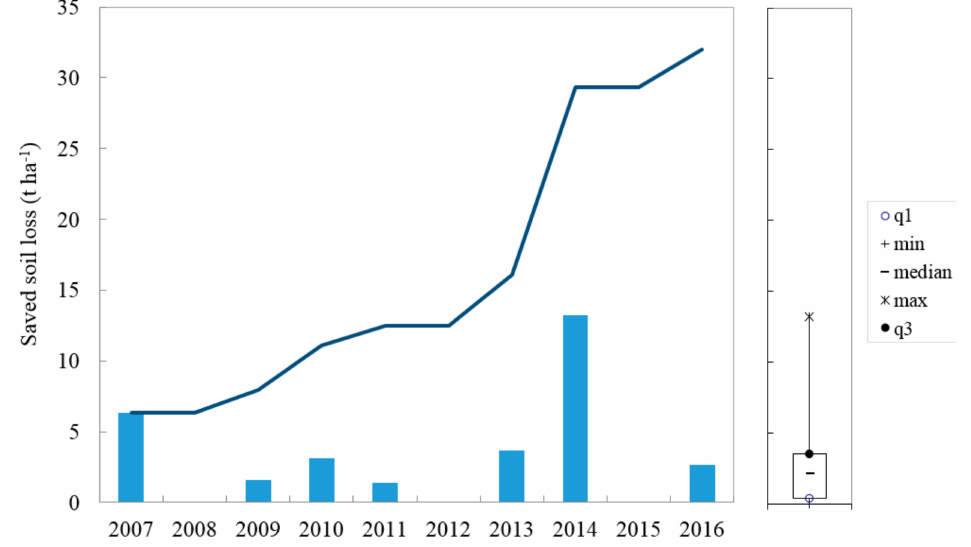
Figure 11. Impact of BMP scenario on saved soil loss. Solid line is the cumulative saved soil loss, whereas the histogram and the corresponding box-plot refer to the annual saved soil loss (q1 and q3 are the first and the third